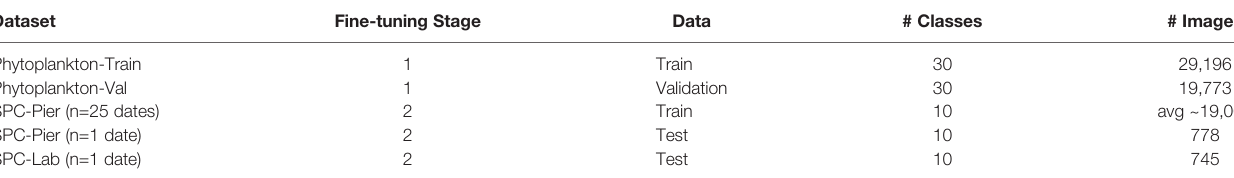
TABLE 1 | Overview of training, validation, and test datasets to train the SPC+CNN. Dataset